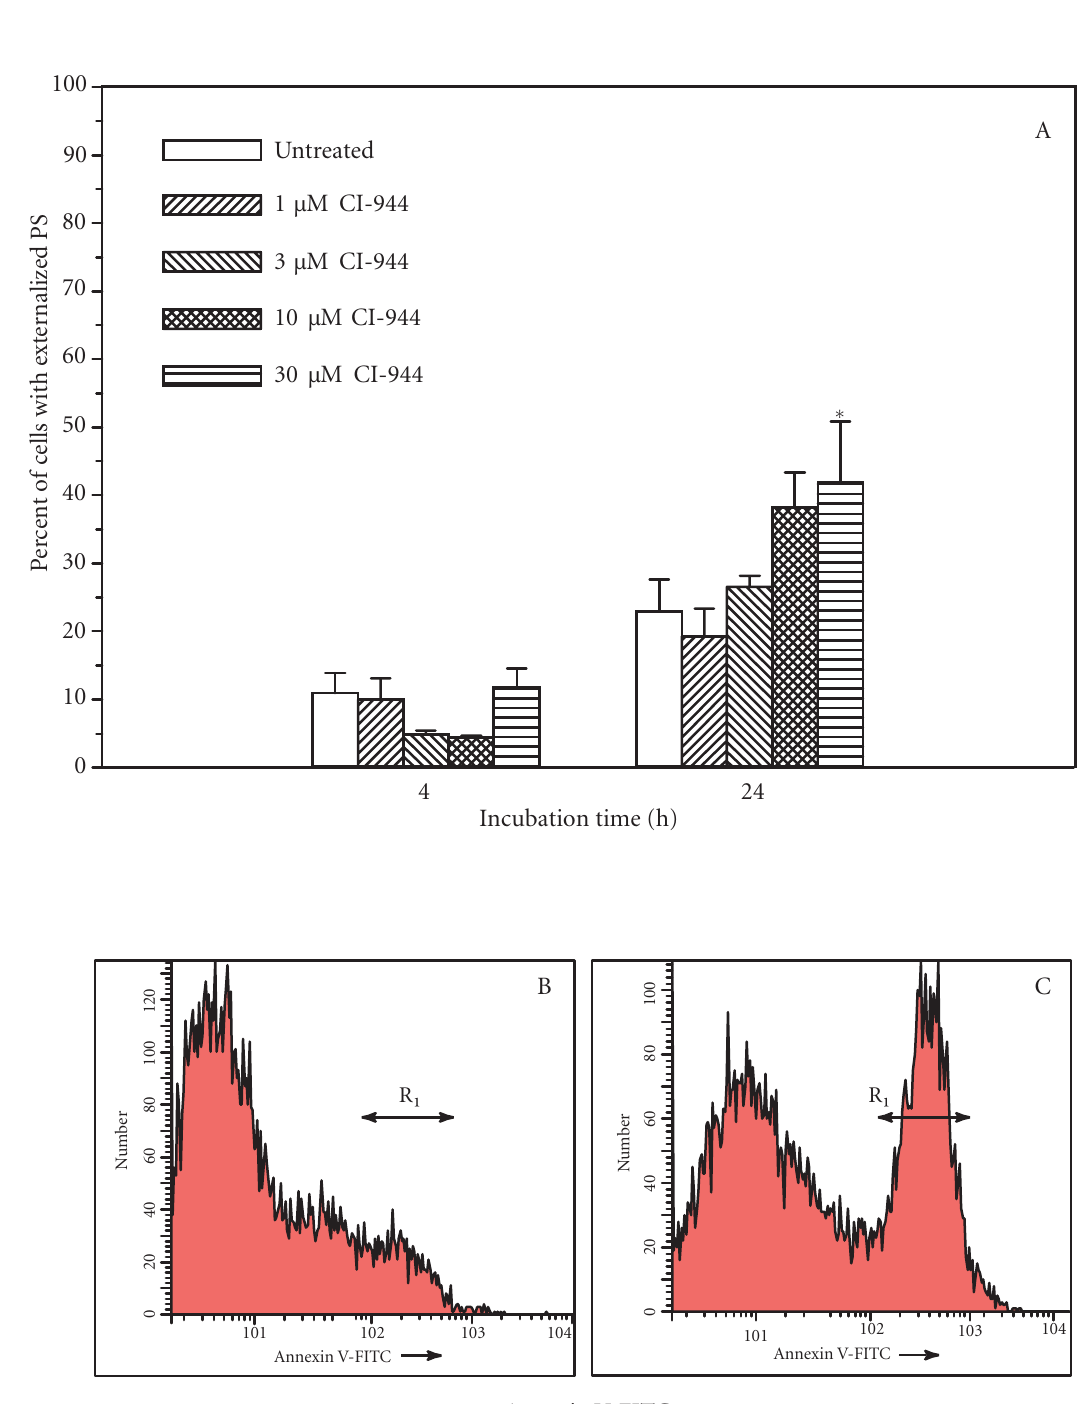
Figure 7: Externalization of phosphatidyl serine (PS) in rat peripheral blood lymphocytes exposed to CI-994 for 4 or 24hours. (A) Exter- nalized PS in the cellular membrane was detected by flow cytometry and annexin V-FITC stain. Mitogen (concanavalin A, 0.63 µ g/ml) was added to all lymphocyte cultures at time zero. Data represent the mean ± SE of at least 4 individual experiments. ∗ Significantly different from control using one way ANOVA and a Tukey post hoc test ( p < 0 . 05 ). Representative PS histograms of (B) untreated rat peripheral blood lymphocytes and (C) lymphocytes treated with 30 µ M CI-994 for 24hours. R 1 = gated annexin V-FITC